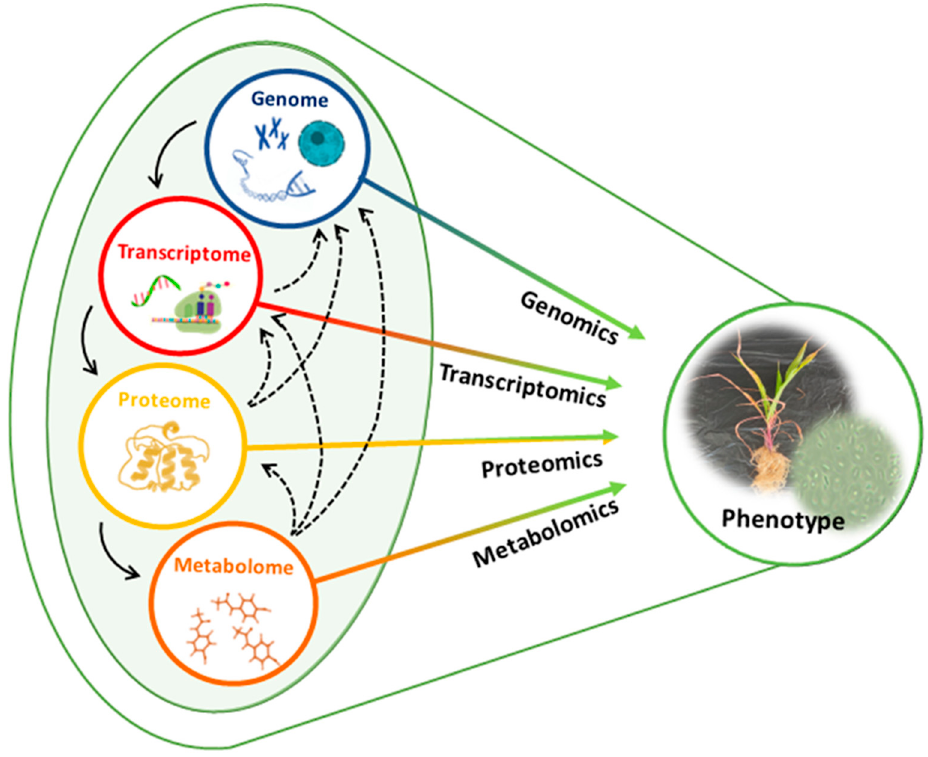
Figure 4. Omics technologies in systems biology. The omics cascade shows the flow of information from gene level to the metabolome with metabolomics being the closest link to the phenotype.